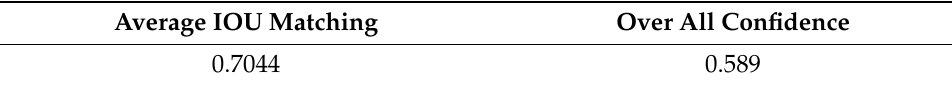
Table 2. Evaluation metrics associated to the bounding box predictions.